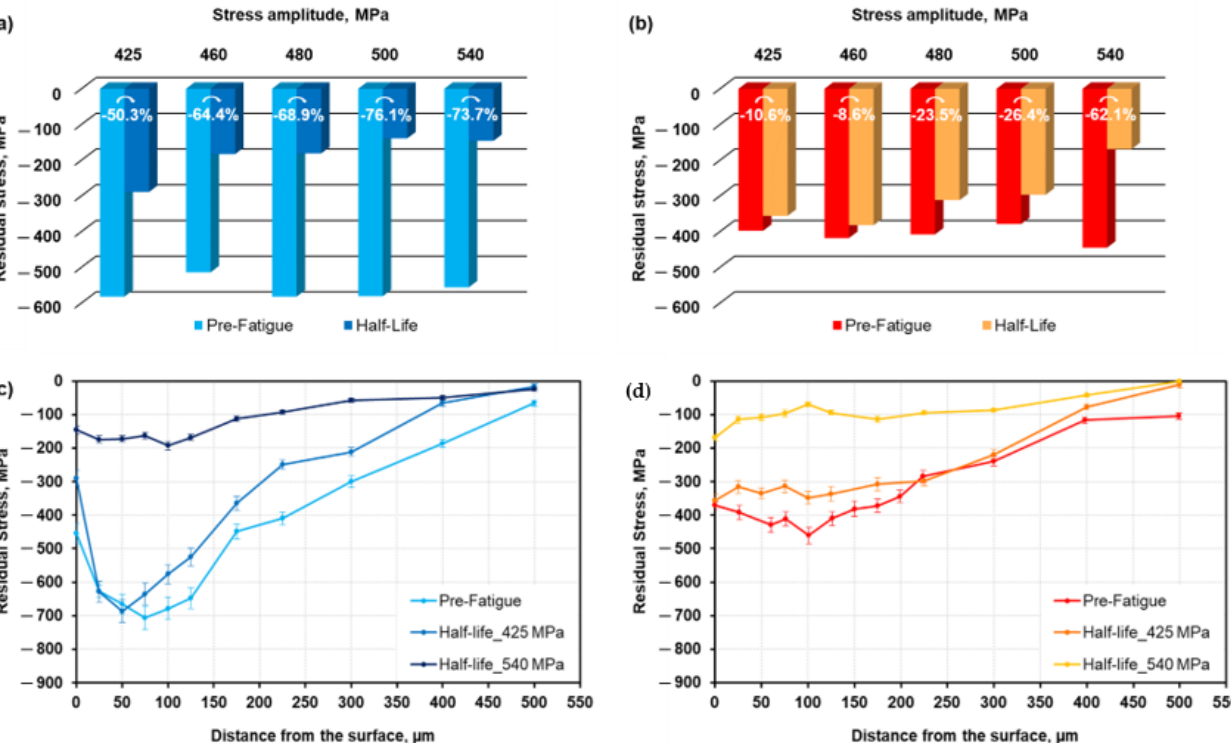
Figure 7. Residual stress stability: Comparison of pre-fatigue and half-life surface residual stress values (N B /2) for varying stress amplitudes and comparison of pre-fatigue and half-life residual stress depth profiles (fatigued at lowest and highest stress amplitude) for (( a ) + ( c )) dr_855N_RT and (( b ) + ( d )) dr_855N_550 °C condition.